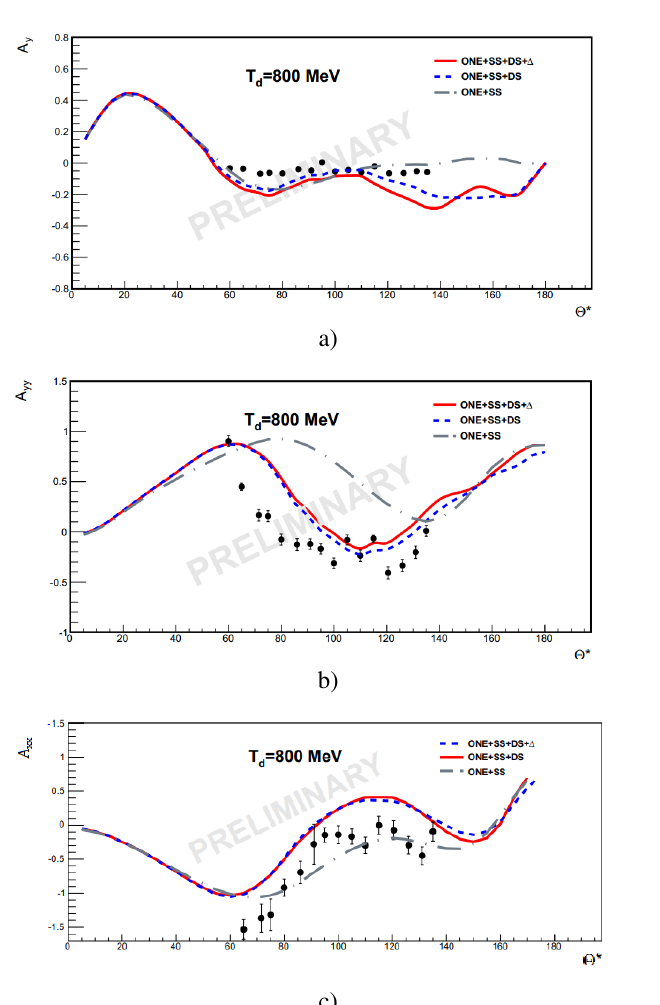
Figure 3. Angular dependencies of the vector A y and tensor A yy , A xx analyzing powers for the dp-elastic scattering at 800 MeV. The curves are described in the